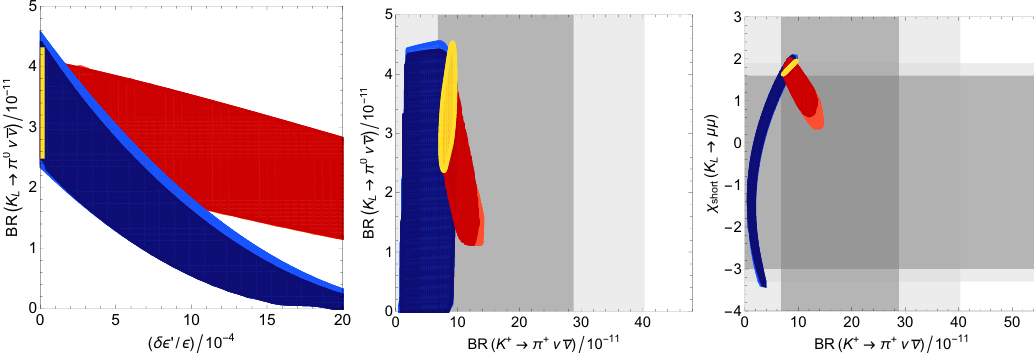
Figure 7. The correlations of observables in the Kaon sector in G SM scenarios at 95% CL for the SM, as well as for M VLQ = 10 TeV [darker colours] and M VLQ = 1 TeV [lighter colours]. The colours correspond to the SM prediction [Yellow] and the VLQ-representations D [Blue] and Q V [Red]; the results for T u;d and Q d are very similar to the former and the latter, respectively. Dark and light grey bands show experimental measurements at 1- and 2 (cid:27)